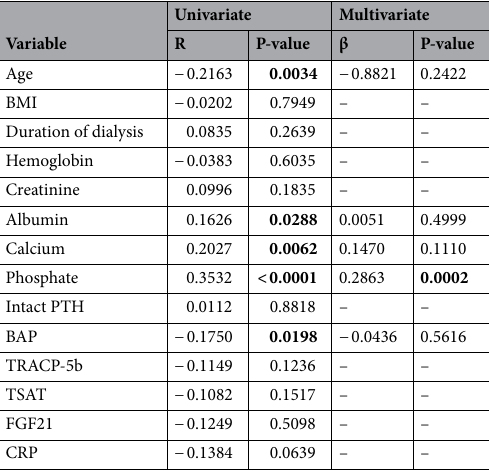
– Table 3. Univariate and multivariate analysis between crystalline CaPi amounts and serum parameters in the hemodialysis patients. Significant values are in bold. BMI body mass index, PTH parathyroid hormone, BAP bone specific alkaline phosphatase, TRACP-5b tartrate-resistant acid phosphatase-5b, TSAT transferrin saturation, CRP C-reactive protein.